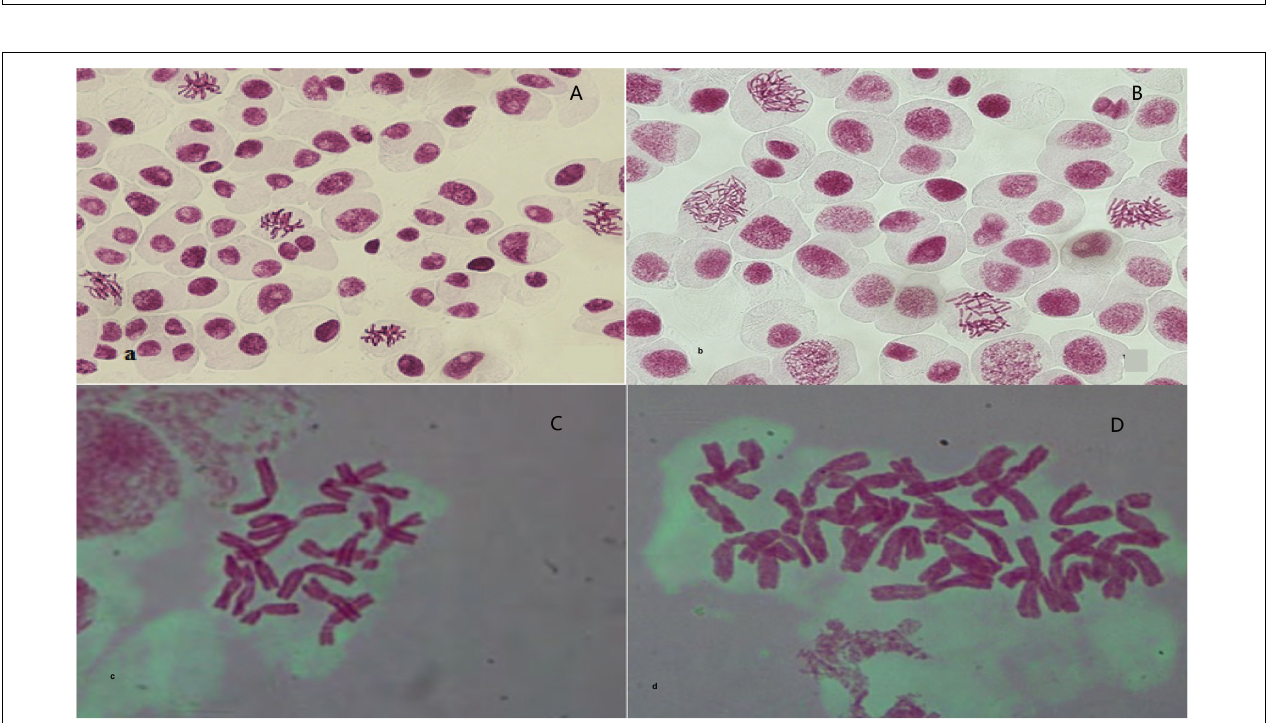
FIGURE 1 | Linea histograms of the relative fluorescence intensity of garlic with FCM. (A) Diploid (2n = 2x = 16). (B) Putative tetraploid (2n = 2x = 32).